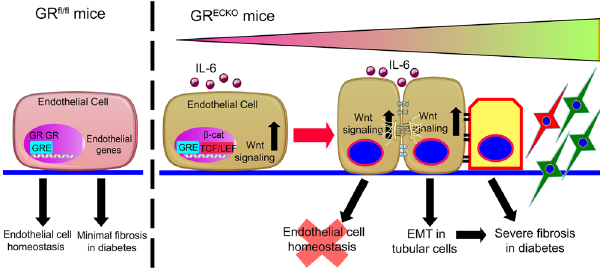
Fig. 8 Graphical representation of the role of GR in endothelial cell homeostasis. GR is crucial for endothelial cell homeostasis and its loss causes homeostatic disruption through release of the pro-in fl ammatory cytokine IL-6 and aberrant activation of Wnt signaling which lead to defective fatty acid oxidation and associated mesenchymal